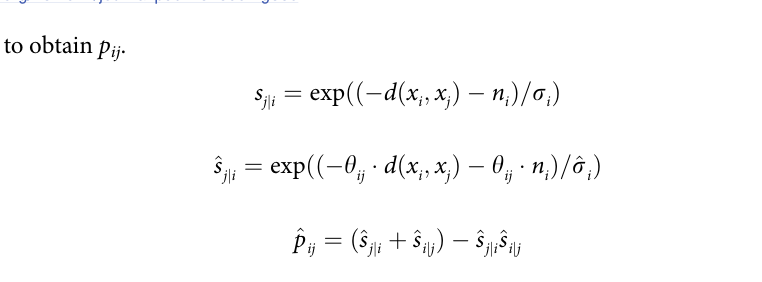
Fig 5. Haisu does not compromise the embedding of cells that do not have a label in the input graph. We depict 0% and 100% replacement of the TA-1 label with a ‘dummy’ label that is not present in the hierarchy across t-SNE, UMAP, and PHATE. Even at high strength values (str) of the hierarchical distancing factor, Haisu maintains relationships in the embedding circled in the figure. Notably, TA 1 cells remain close to Cycling TA cells across the embeddings at 100% removal despite their distance in the hierarchy graph. Thus, we do not comprise the integrity of each NLDR method, allowing for the observation of unknown classes in the context of a strongly influential, known hierarchy.